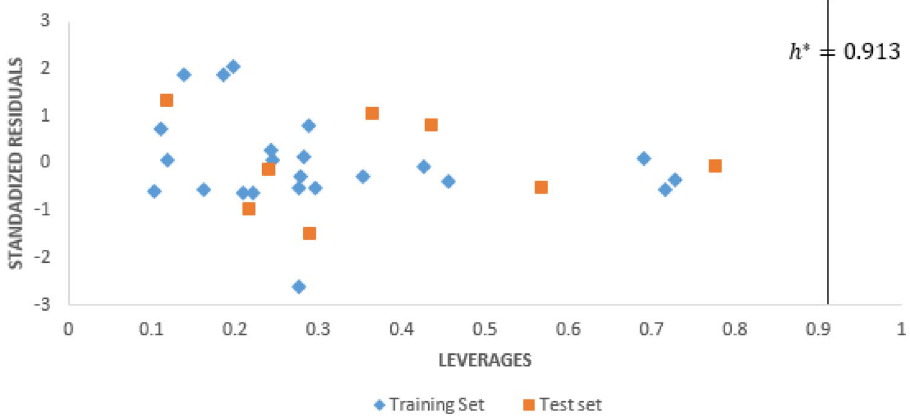
Fig. 2 Williams plot for an external validation of activities of indolyl-3-ethanone-α- thioethers derivatives. Cut-off value h* = 0.913